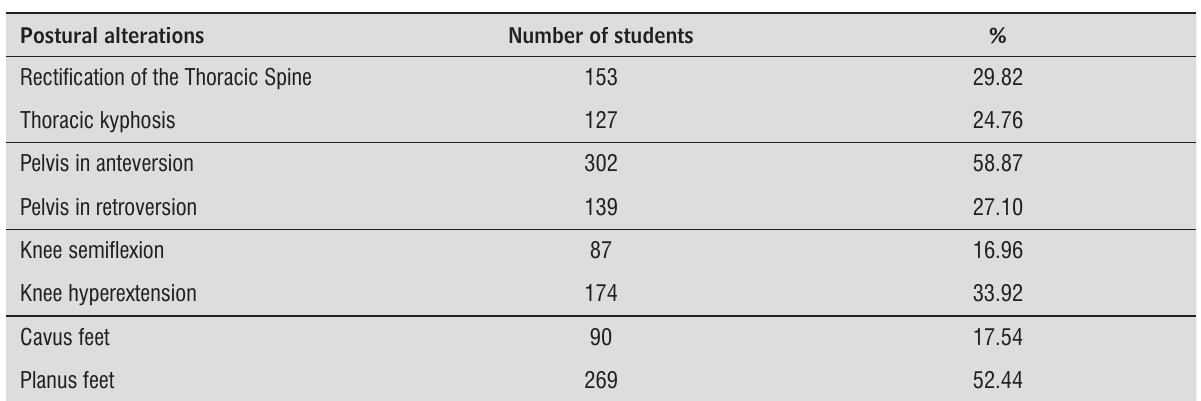
Table 3 - Alterations in the positioning of the head, shoulders, neck, cervical and thoracic spines, pelvis, knees and feet